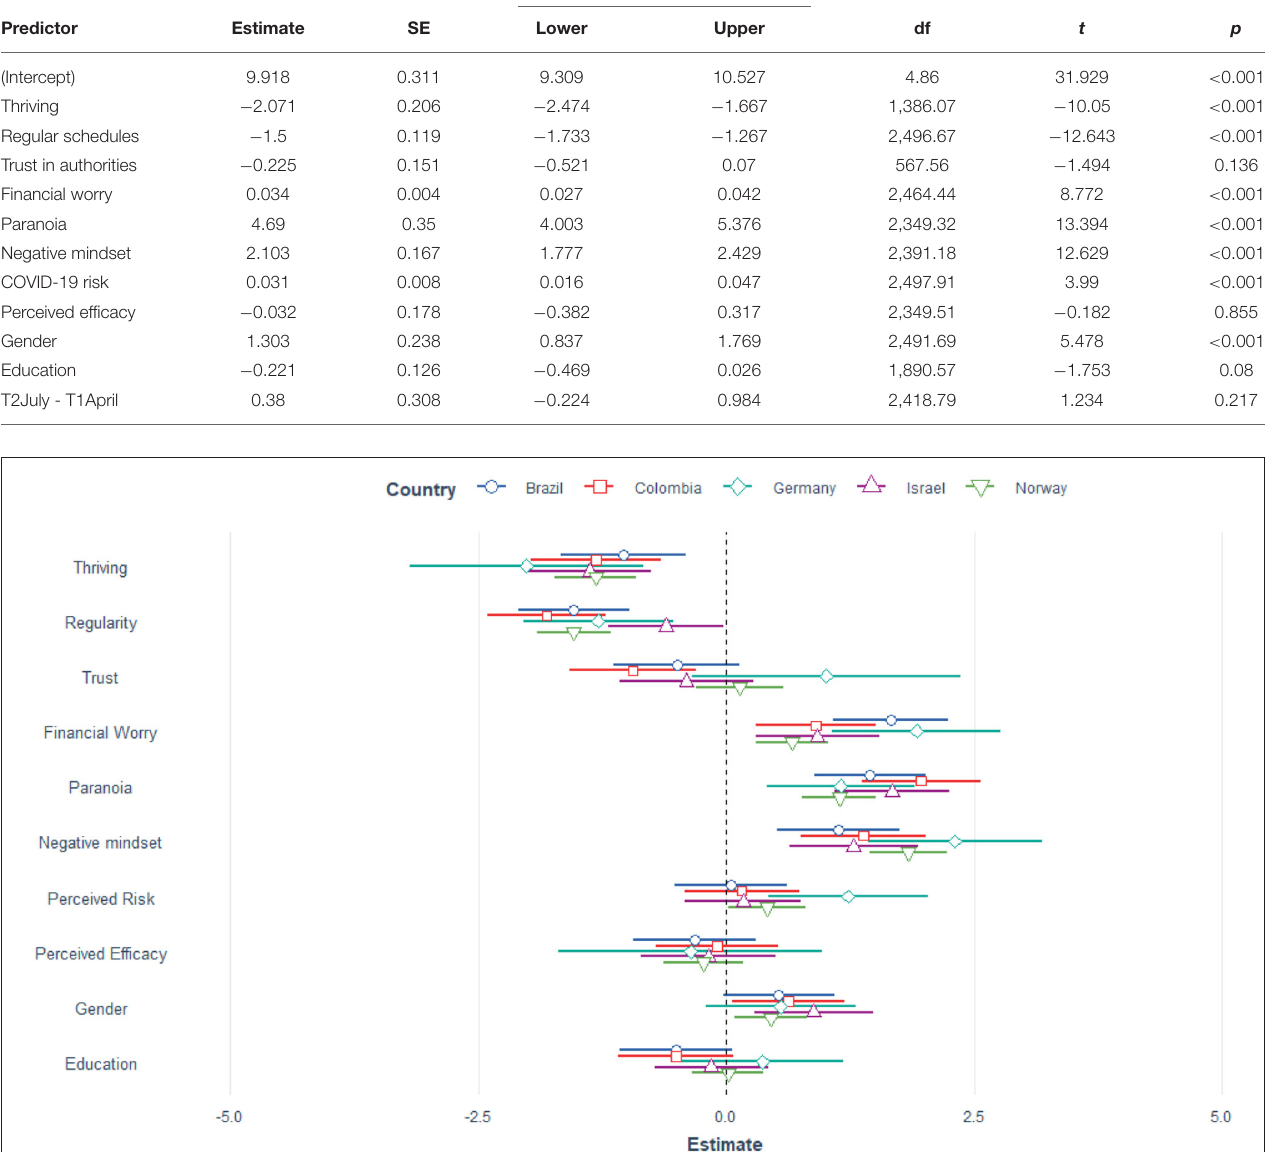
FIGURE 2 | Estimates for the 10 predictors of general distress per country, April data. Gender is coded as male = 0, 1 = female, 2 =